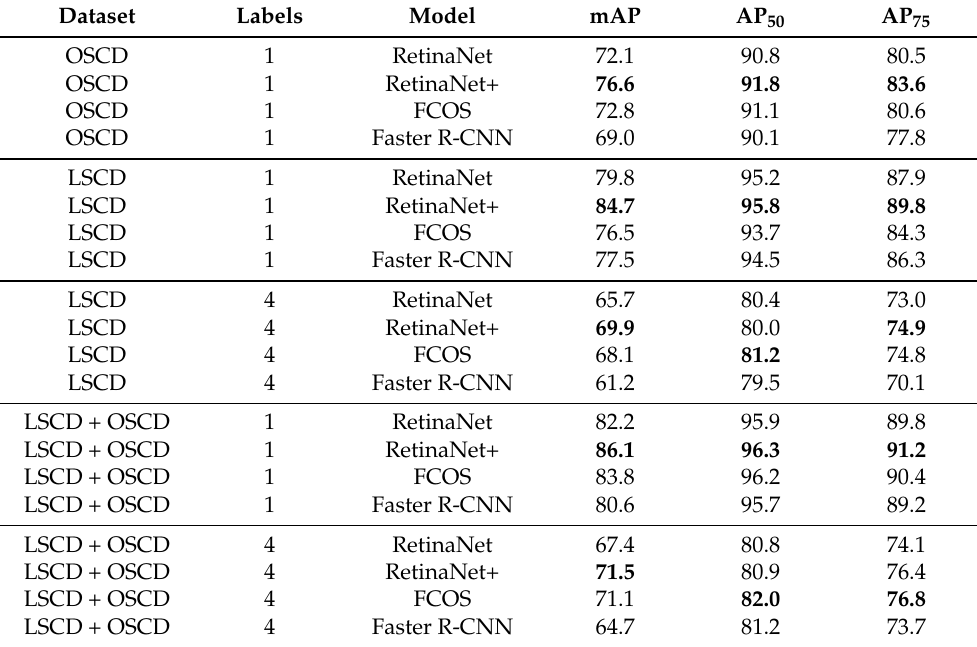
Table 2. Comparison of detection performance between three state-of-the-art methods on SCD. For the evaluation of LSCD, 1 and 4 labels are all evaluated. LSCD + OSCD means the detectors are firstly pre-trained in OSCD and then finetuned in LSCD. RetinaNet+ represents that GIoU loss was used. Dataset Labels Model